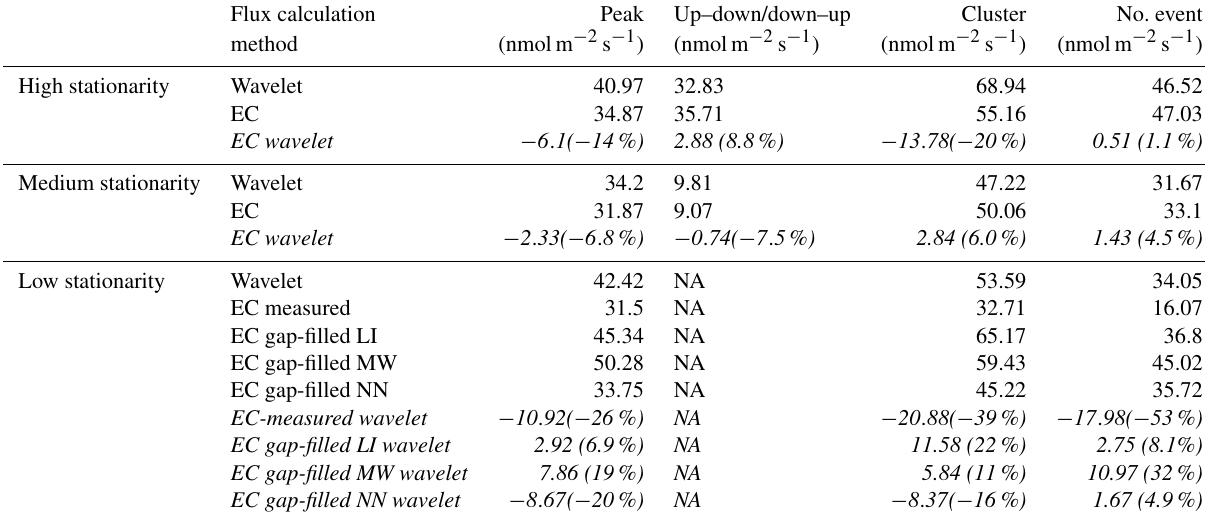
Table A1. Mean methane fluxes for the wavelet method and EC method, split into three stationarity categories. For the lowest stationarity, in addition to measured EC values, model results by the three different gap-filling approaches, linear interpolation (LI), moving window (MW) and neuronal network (NN), are given. Absolute flux values are given in usual font, while italic font indicates flux differences between EC and wavelet processing; numbers in brackets give the percentage deviation. NA stands for not available.